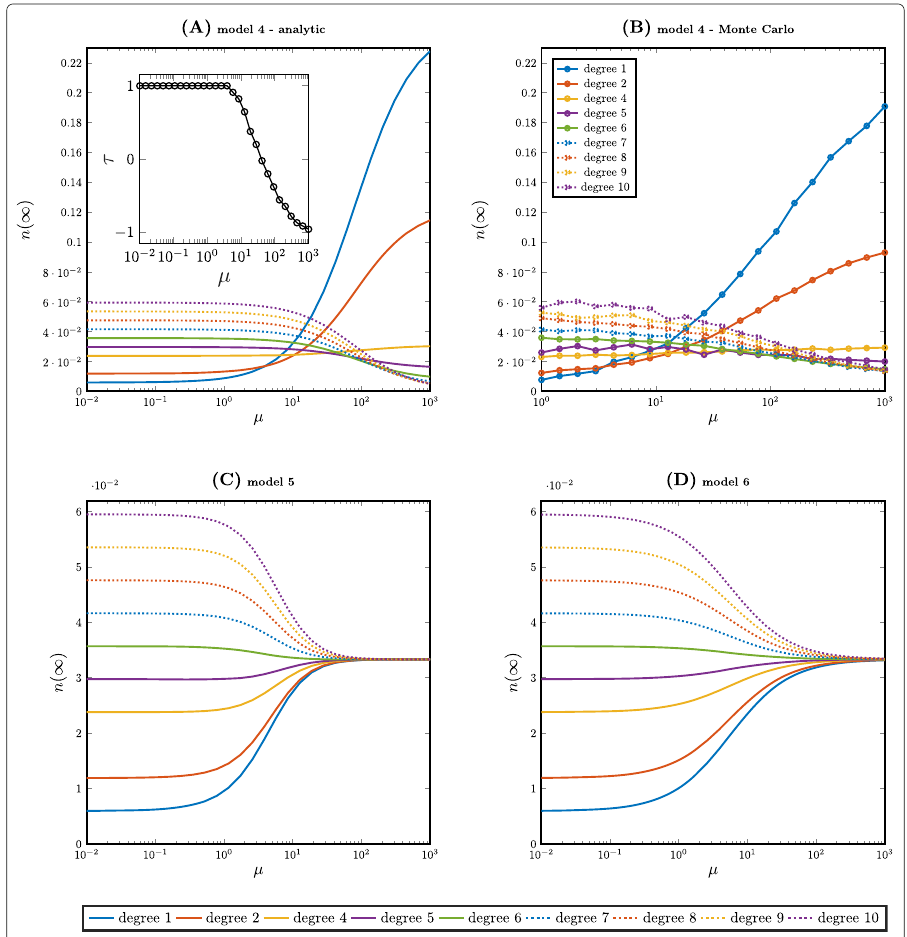
Fig. 5 Steady states as a ranking application. Models 5 and 6 on the bottom panels (C) and (D) behave in the limit for the fast walker ( μ → ∞ ) as a Markovian passive edge-centric random walk, where the steady state is uniform across the symmetric network. In the small- μ limit, the steady state probability is proportional to the degree, like in the Markovian active node-centric walk. In model 4 of panel ( a ), this behaviour does not hold true. Indeed, when μ → ∞ , the steady-state residence probability is high when degree is low. This inversion with respect to the degree-based ranking is captured by the inset of panel ( a ). On this inset, the evolution of τ , which denotes Kendall’s Tau coefficient, is represented in function of μ . When Kendall’s Tau is one, the rankings of panels ( a ) and ( c ) or ( d ) are the same; when it is -1, the two rankings are reversed. There is no link between the two when it is 0. Panel ( b ) displays the result of Monte-Carlo simulation of 10 4 trajectories of a walker subject to the motion rules of model 4, in the range of values of μ corresponding to the reversed ranking. These simulations do account for the presence of cycles, and confirm quantitatively the ranking predicted by the analytical formula. We have selected η = 1 = λ for all plots. The strongly connected symmetric network is Erdös-Rényi with 30 nodes and connection probability 1